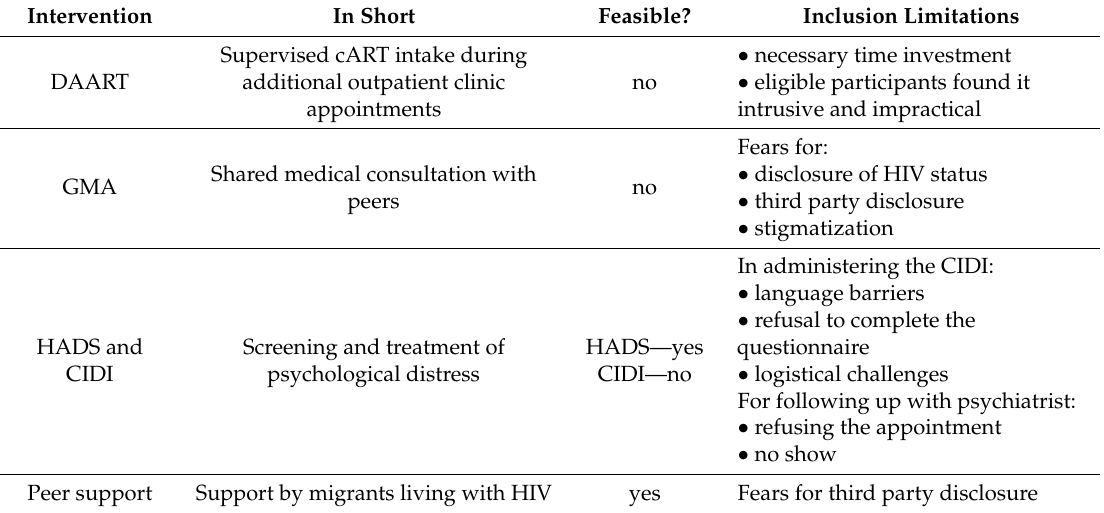
Table 2. Summary of interventions’ descriptions, feasibility, and